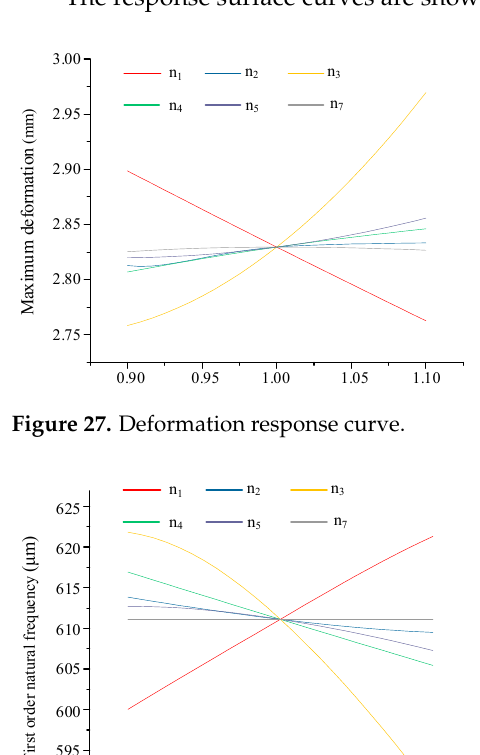
Figure 26. Correlation of 7 optimization parameters to total mass sensitivity.